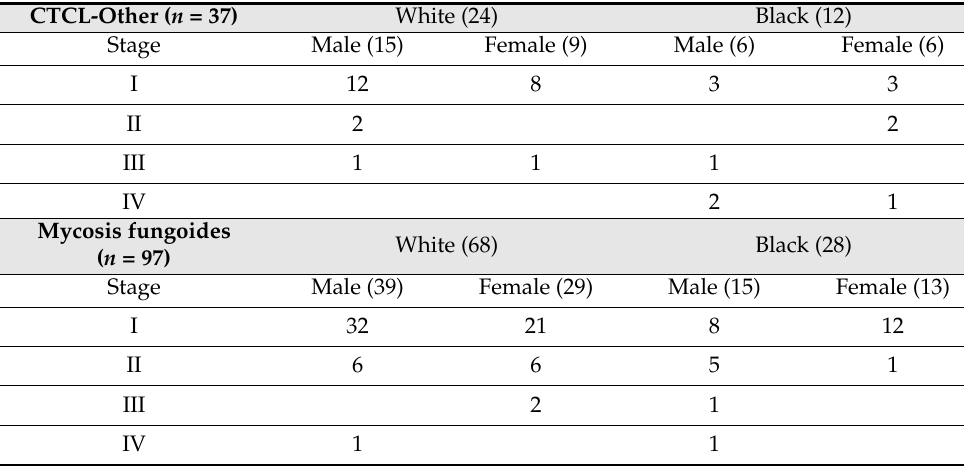
Table 3. Staging and disease-related characteristics based on race and